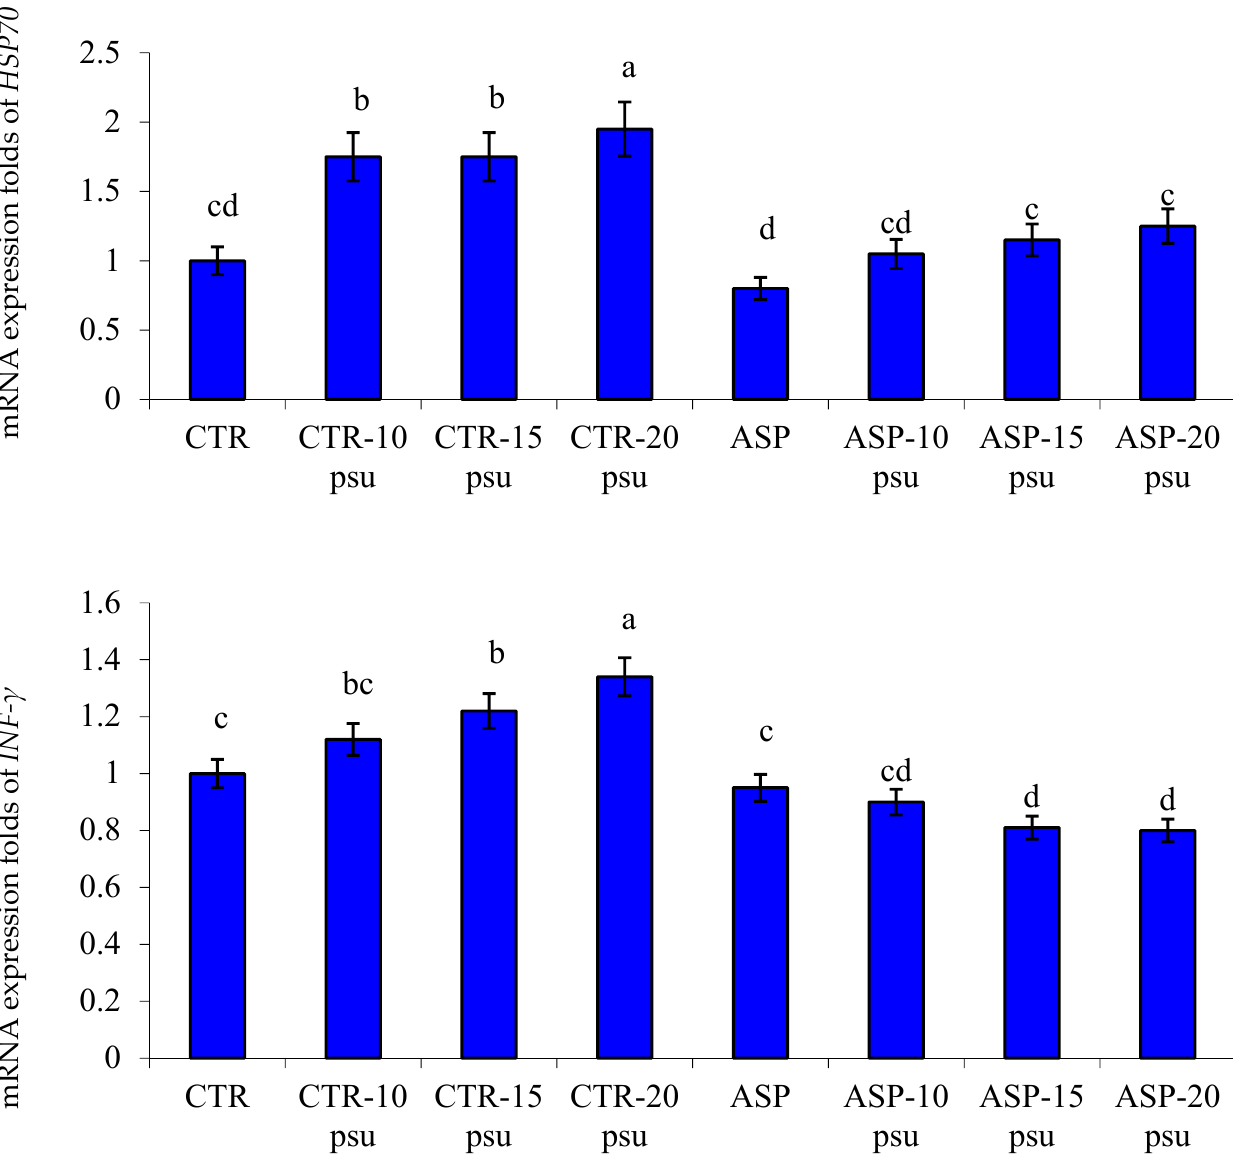
Figure 2. Changes in the mRNA expression folds of hepatic HSP70 and INF- γ genes in Nile tilapia fed a basal diet (CTR) in comparison to those fed on diets supplemented with Aspergillus oryzae (ASP) for 12 weeks and then exposed to different salinity levels for 15 days (10, 15, and 20 psu). Bars of each variable assigned by different letters are statistically significant. p values of Two-way ANOVA (ASP = 0.022, salinity = 0.034, and ASP × salinity interaction = ˂ 0.001).